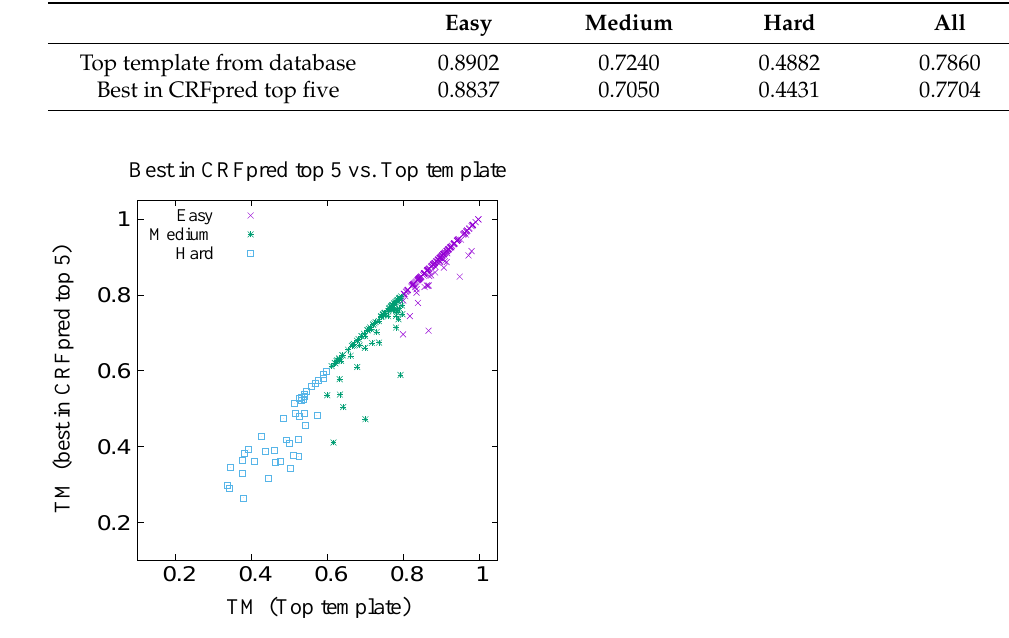
Table 6. Summary of Average TM scores of 300 targets.